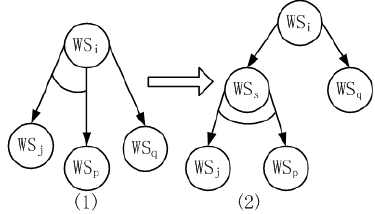
Fig. 2. The Transfer Method for Mixed Logical Relation